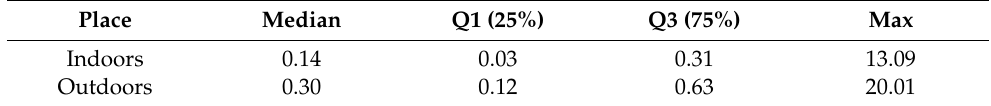
Table 3. Descriptive statistics parameters (median, 25th, and 75th percentiles and maximum) for the E (V/m) values measured in indoor and outdoor places in Catalonia (Spain).